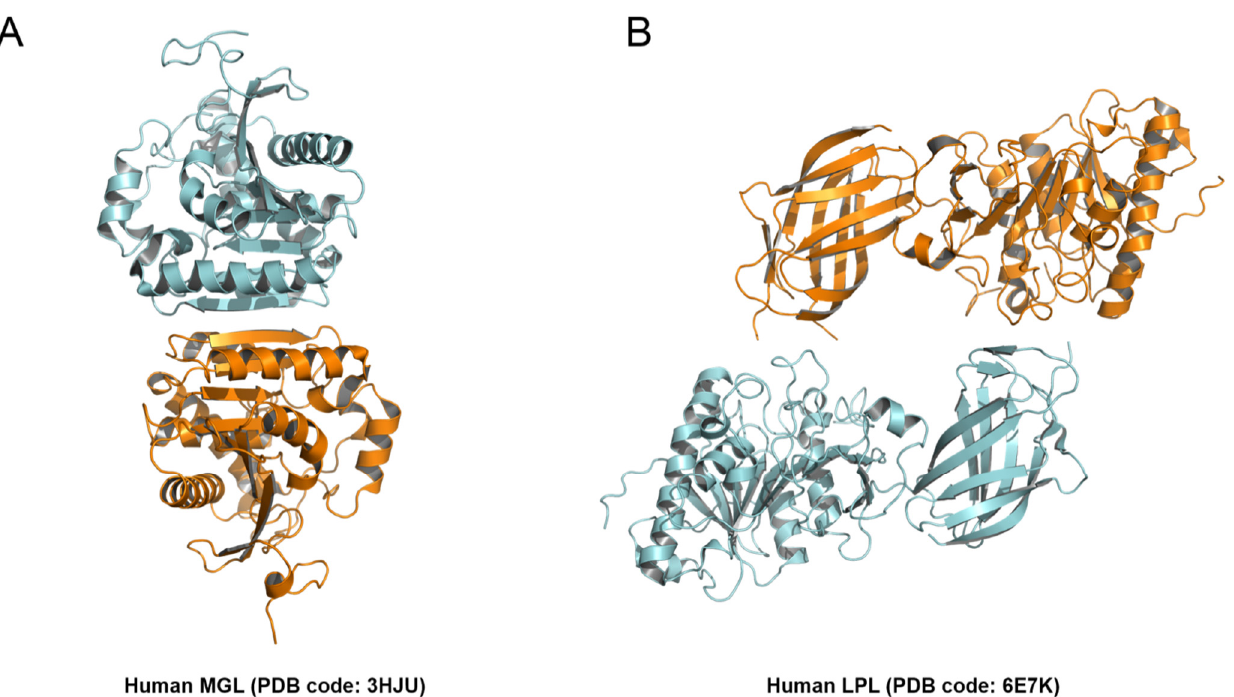
Figure 5. Dimerization interface of human PLAs. ( A ) Dimeric structure of human MGL. Each monomer of human MGL are colored in cyan and orange, respectively. ( B ) Dimeric structure of human LPL.